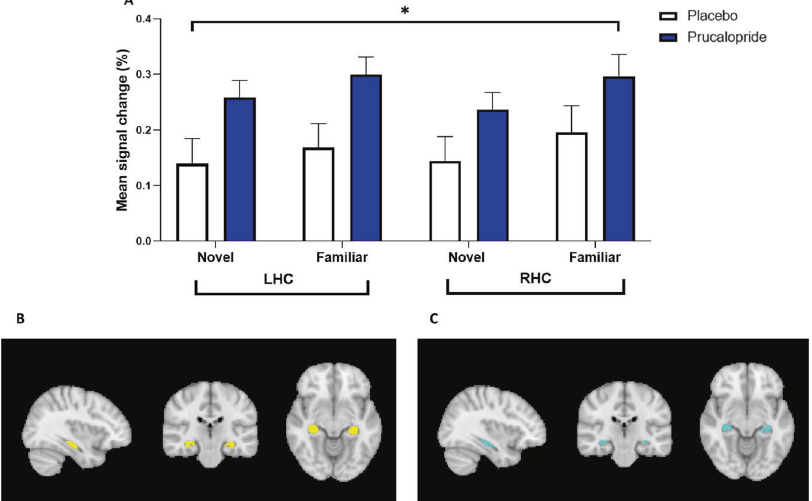
Fig. 3 BOLD percentage signal change extracted from functional left (LHC) and right (RHC) hippocampal mask in response to novel and familiar images. A Group mean of BOLD percentage signal change extracted from LHC and RHC in response to novel and familiar images. Error bars show standard error of the mean. * p < 0.05, signifying a main effect of group on ANOVA. B A functional ROI mask was created for the left and right hippocampus for each contrast of interest by multiplying mean activation for all participants by the anatomical mask at a 50% threshold. LHC and RHC mask in sagittal, coronal, and axial views created for novel mean (yellow); C LHC and RHC mask in sagittal, coronal, and axial views created for familiar mean (light